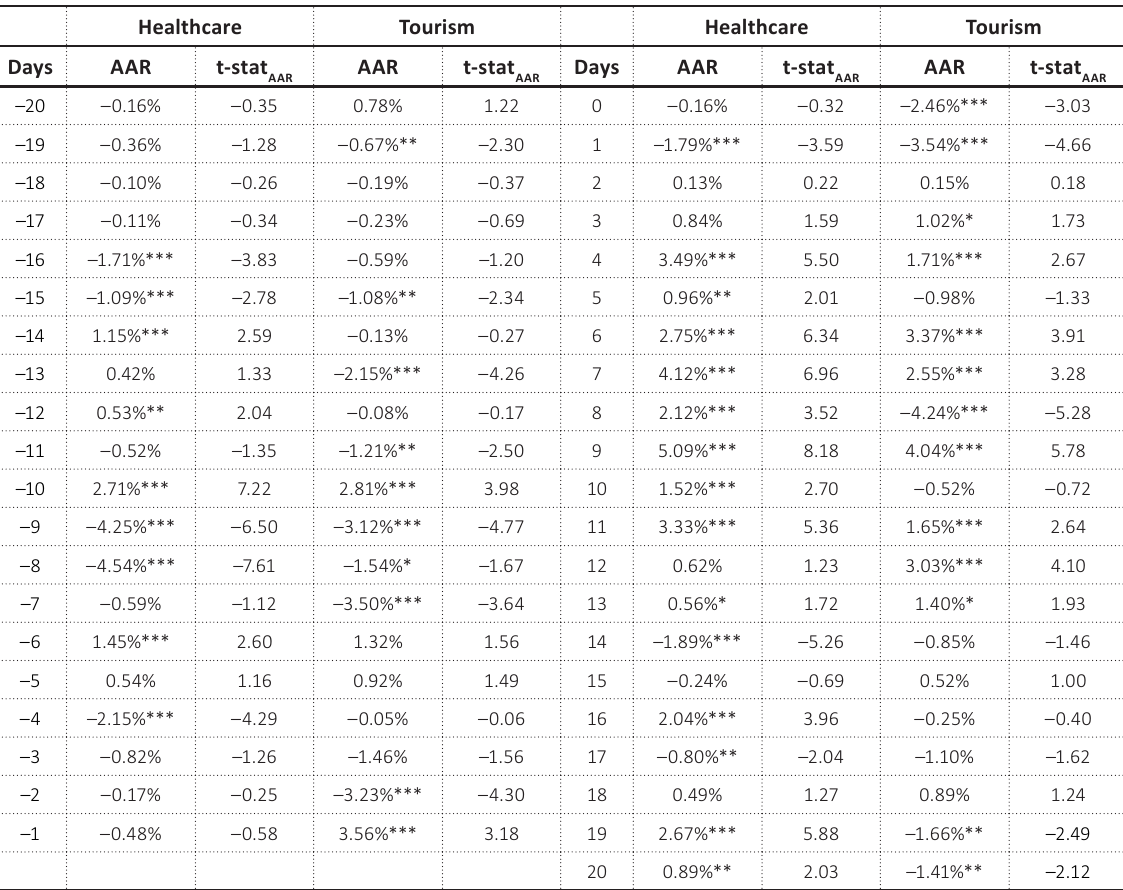
Table 3. Abnormal returns and t-statistics of healthcare and tourism sectors surrounding lockdown announcement